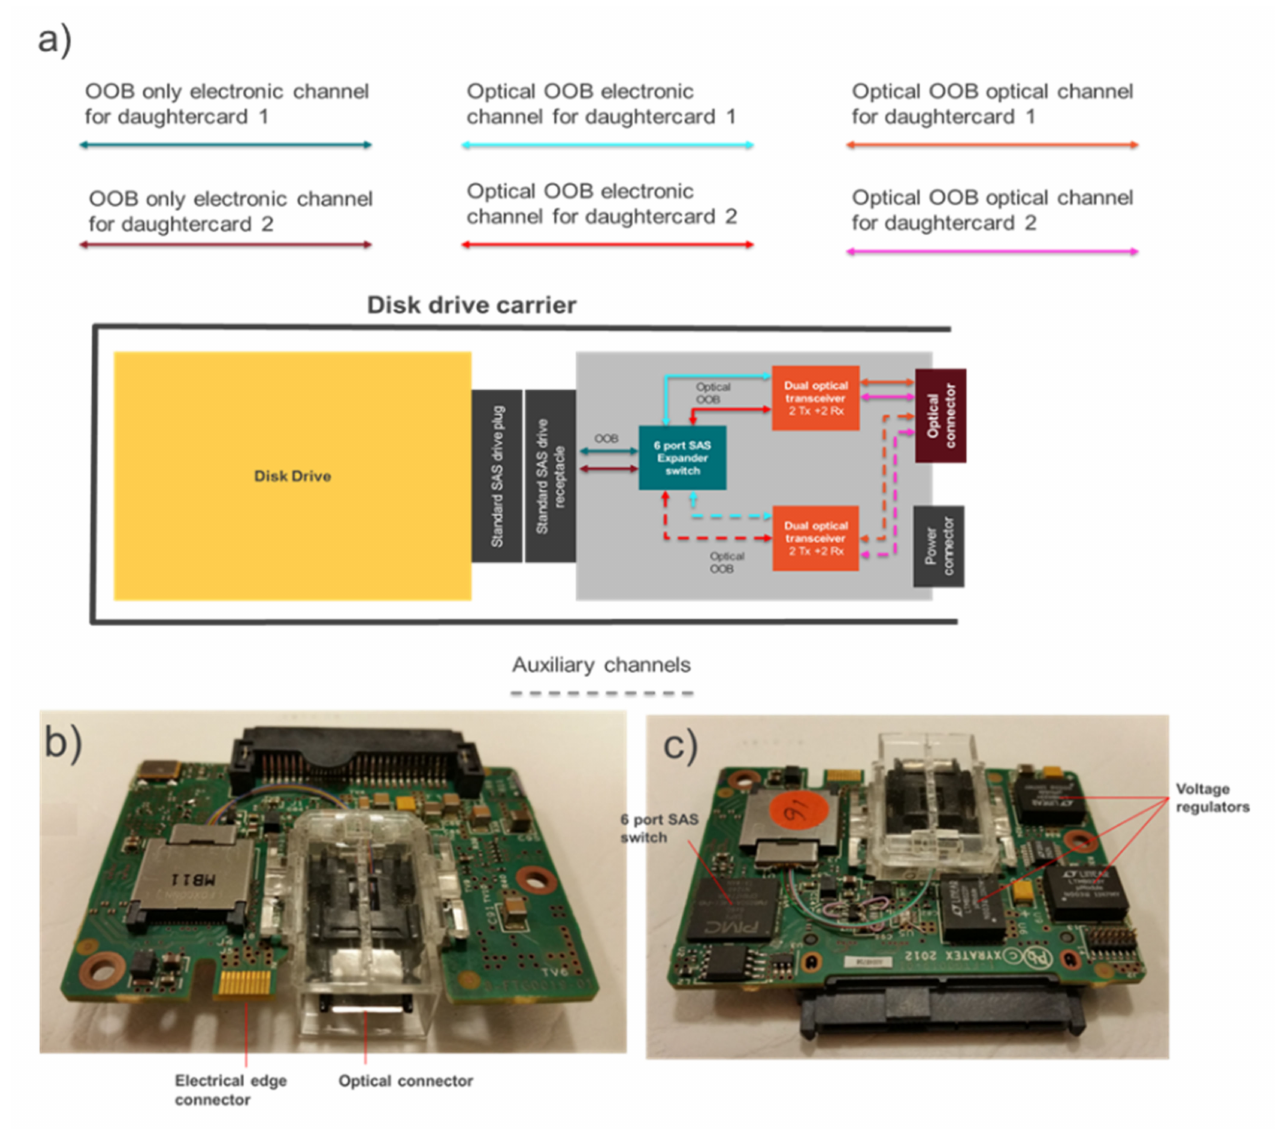
Figure 10. ThunderValley2 optical interface card: ( a ) schematic architecture of optical interface card, ( b ) top side of interface card showing MorningStar connector and first McLink transceiver module, ( c ) bottom side showing SAS switch and second McLink